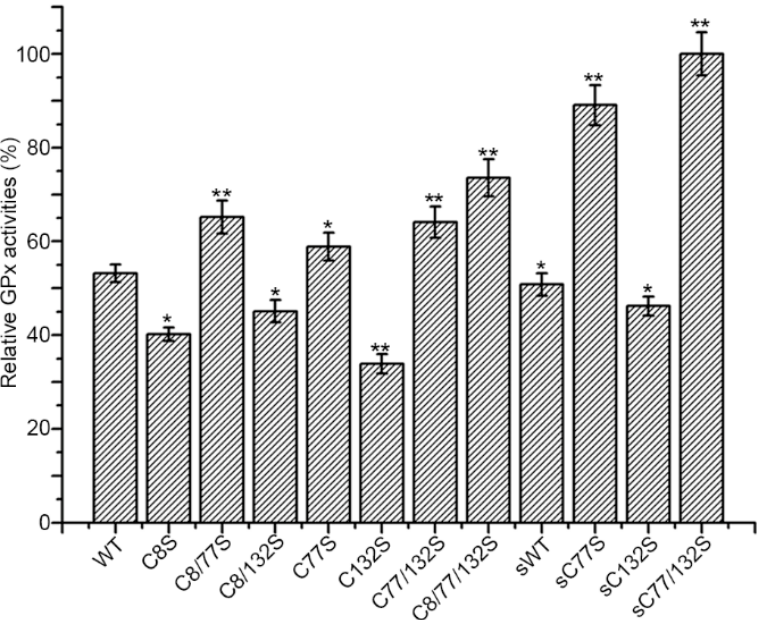
Figure 5. Effect of point mutations on the GPx activity: The GPx activities of WT (Sec − hGPx3) and mutants were analyzed under the same conditions as described in the legend of Figure 1, except 500 µ M H 2 O 2 was used. The activity of Sec − shGPx3 − C77/132S (56.2 U/mg) was defined as 100%. Student’s t − test was used for statistical analysis. The data are presented as the mean ± SD ( n = 3); * p < 0.05, ** p < 0.01. In Sec − hGPx3 − C8/77S, Sec − hGPx3 − C77S, Sec − hGPx3 − C77/132S, Sec − hGPx3 − C8/77/132S, Sec − shGPx3 − C77S, and Sec − shGPx3 − C77/132S, Cys77 was replaced with Ser, and the GPx activities were higher when compared to the mutants that retained